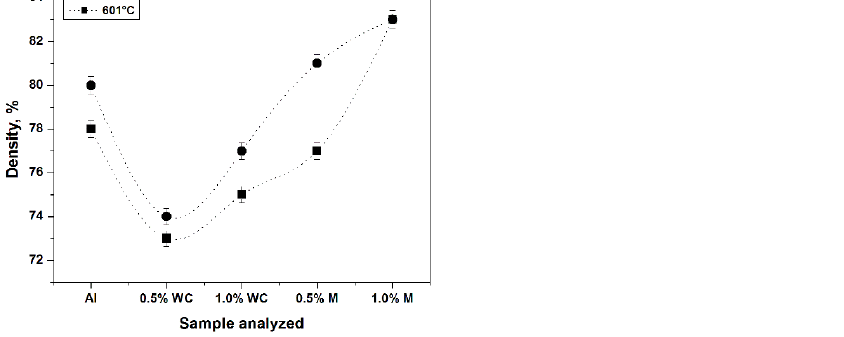
Figure 3. Results of the relative density reached by the samples with different compositions and sintered at different temperatures.